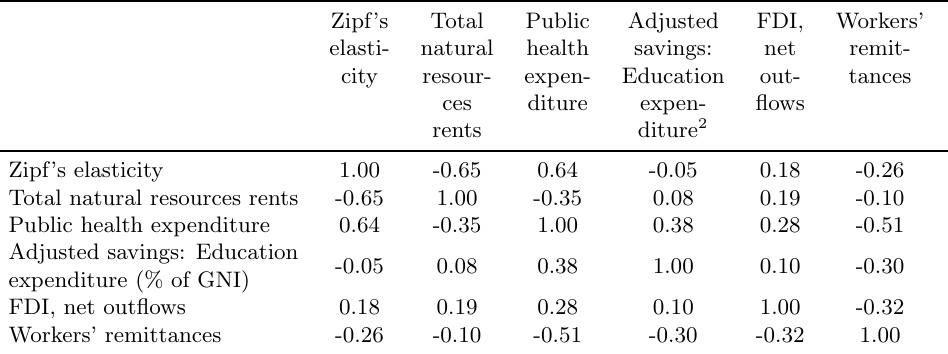
Table 2: Correlation between dependent and independent variables Zipf’s Total Public Adjusted FDI, Workers’ elasti- natural health savings: resour-